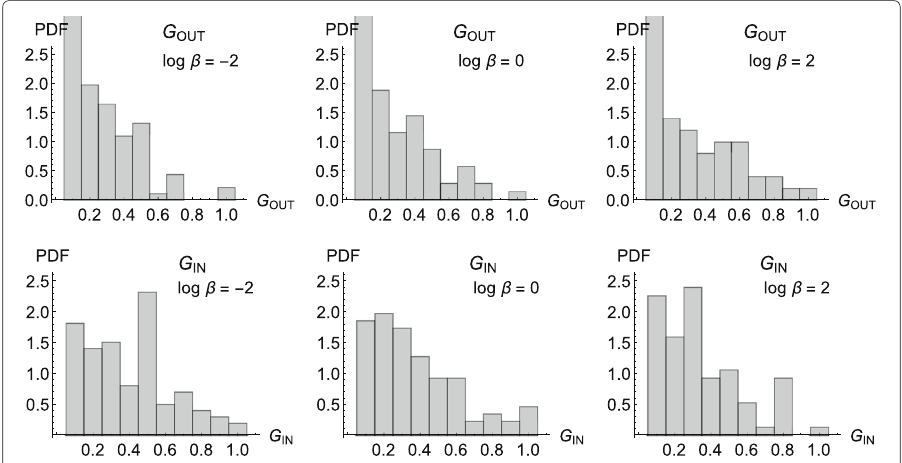
Fig. 3 Histograms of distributions of in- and out- communicability. The histograms of values of G IN and G OUT for the collated network are shown for epistemic weights log β = − 2,0 and 2 as indicated in